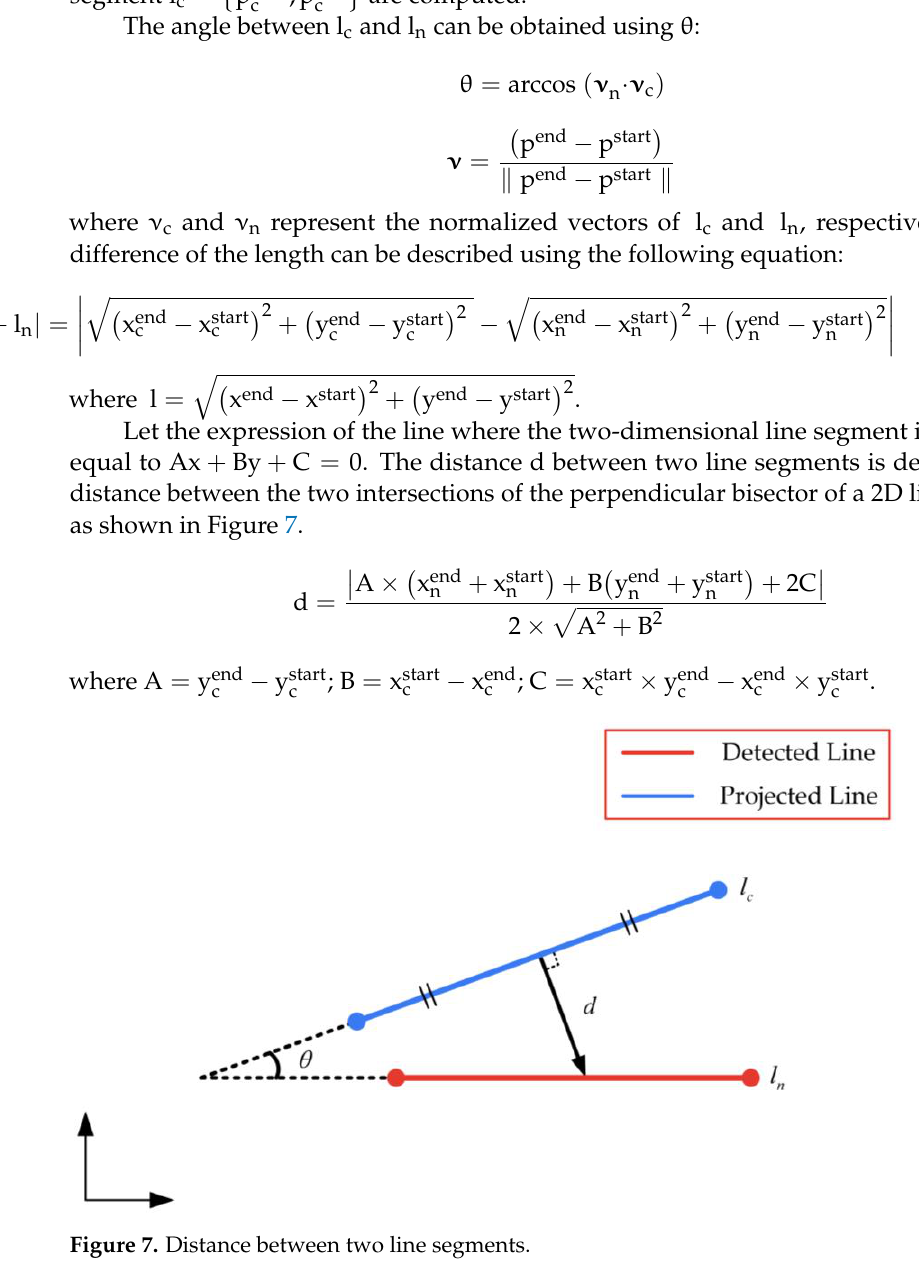
Figure 7. Distance between two line